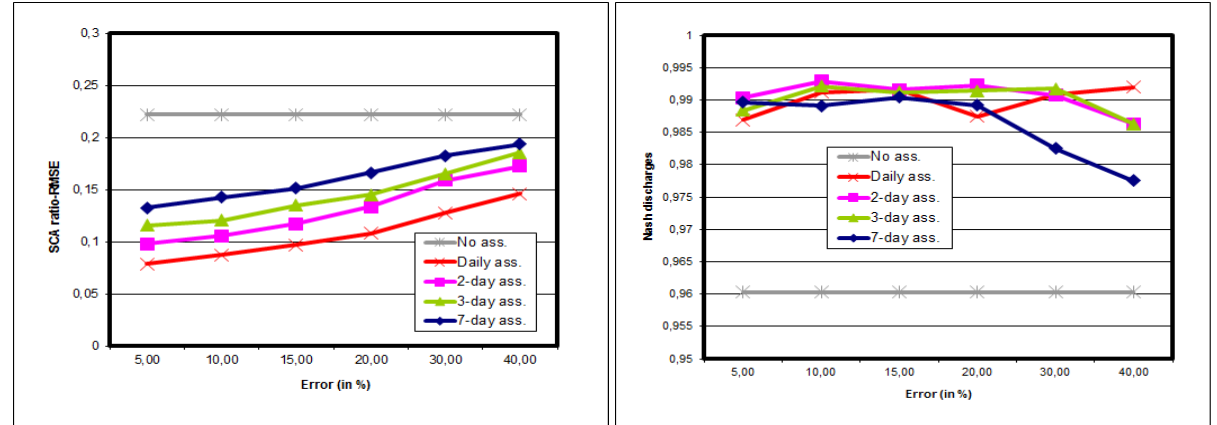
Figure 4. SCA ratio-RMSE ( left ) and Nash ( right ) for the synthetic SCA particle filter assimilation experiments on the area upstream of the Kromericz station with 50